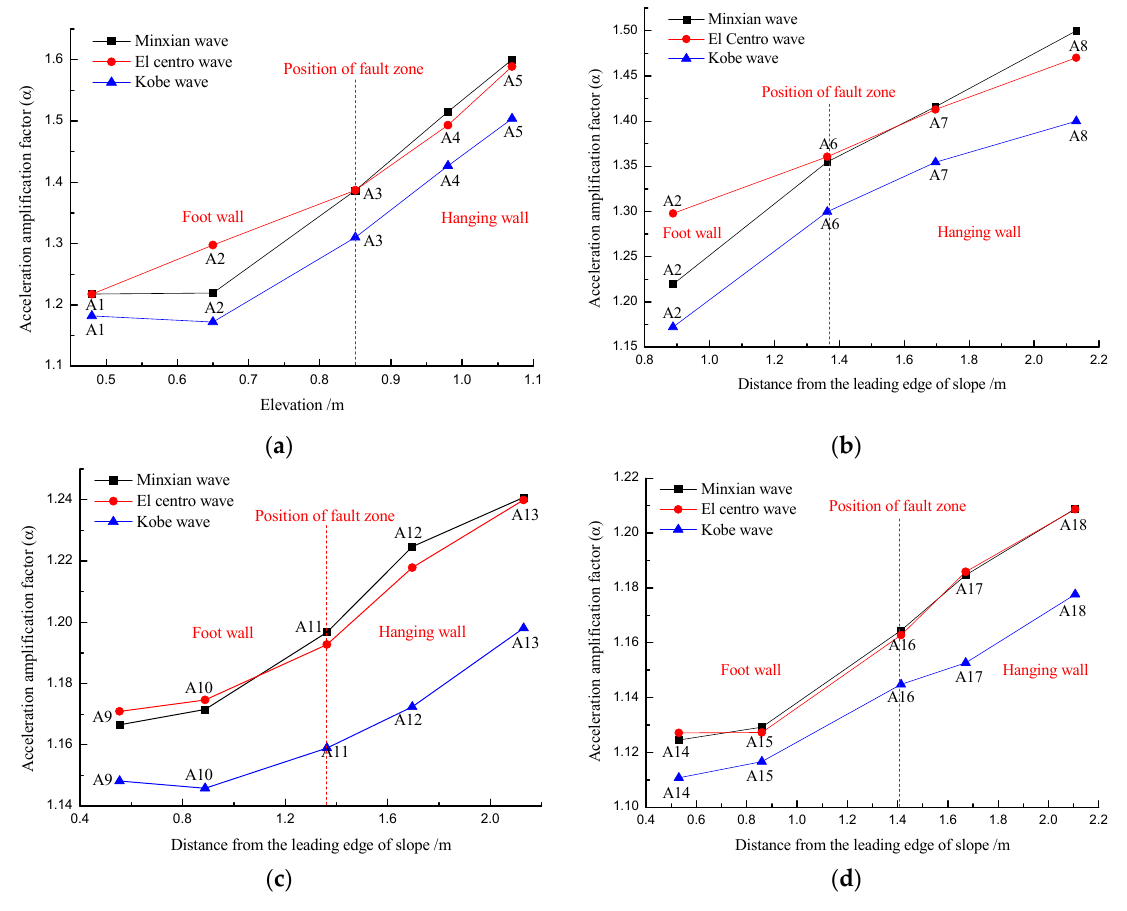
Figure 7. Change of acceleration amplification factors (AAFs) ( a ) with elevation along slope surface, ( b ) in loess stratum, ( c ) at loess–weathered mudstone (L–W) interface, and ( d ) weathered mudstone–mudstone (W–M) interface in response to three types of earthquake waves with an input PGA of a = 0.1 g.